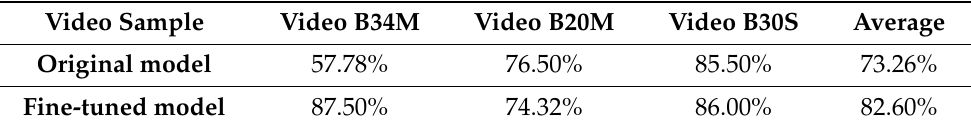
Table 2. Vehicle count improvements.